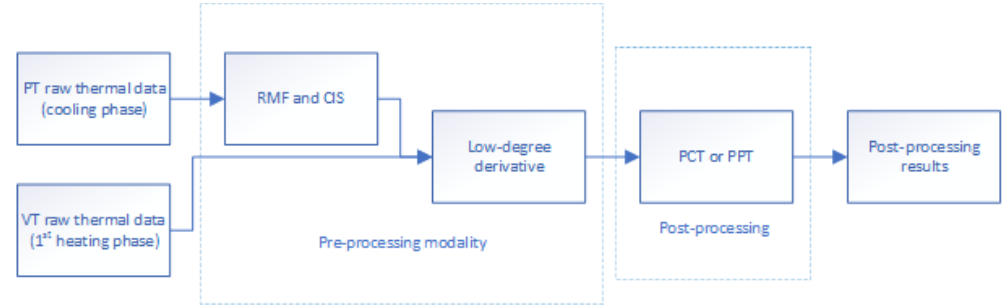
Figure 4. Flow chart of infrared image processing